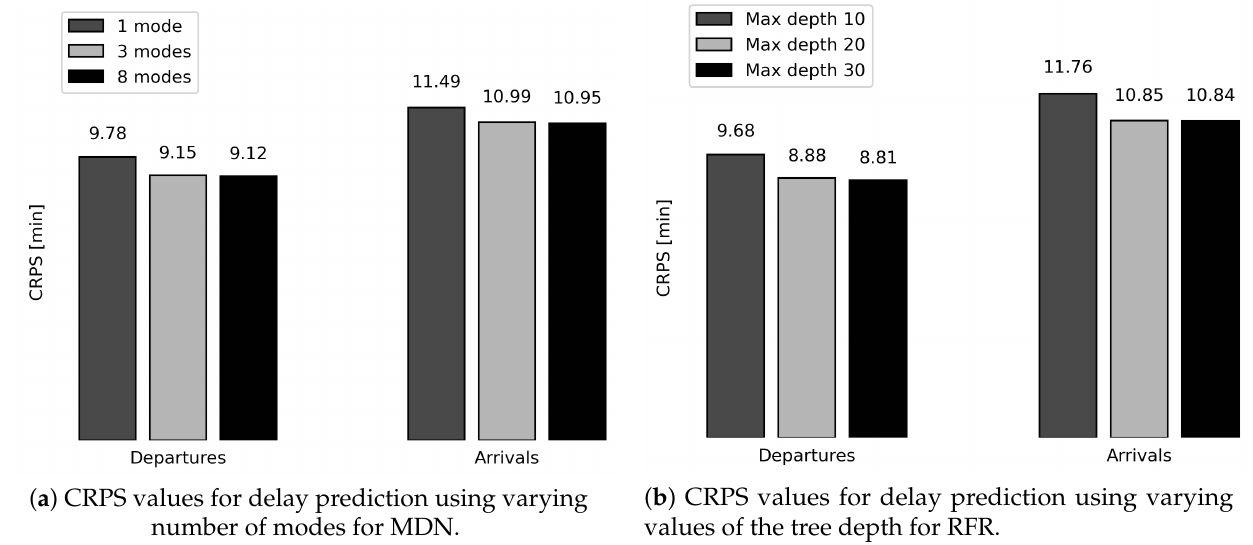
Figure 6. CRPS values obtained when varying hyperparameters in the MDN and RFR